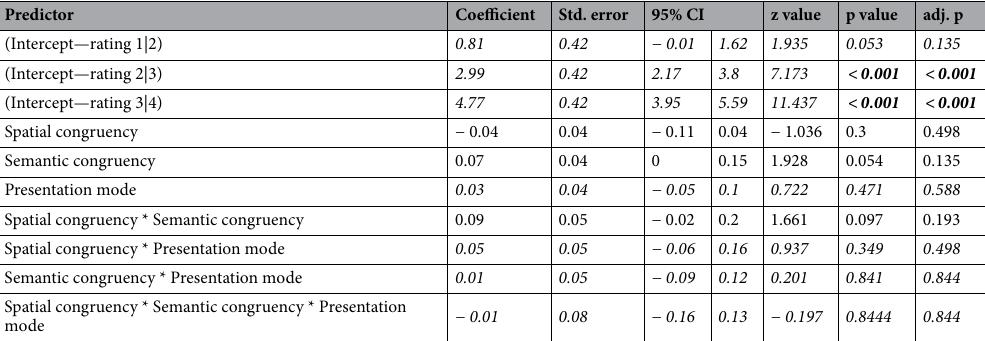
Table 2. Summary of the CLMM fitted for visibility rating in Experiment 2 (masked pictures). The results pertaining to our hypotheses are shown in roman, the remaining results in italics. Bold indicates significant